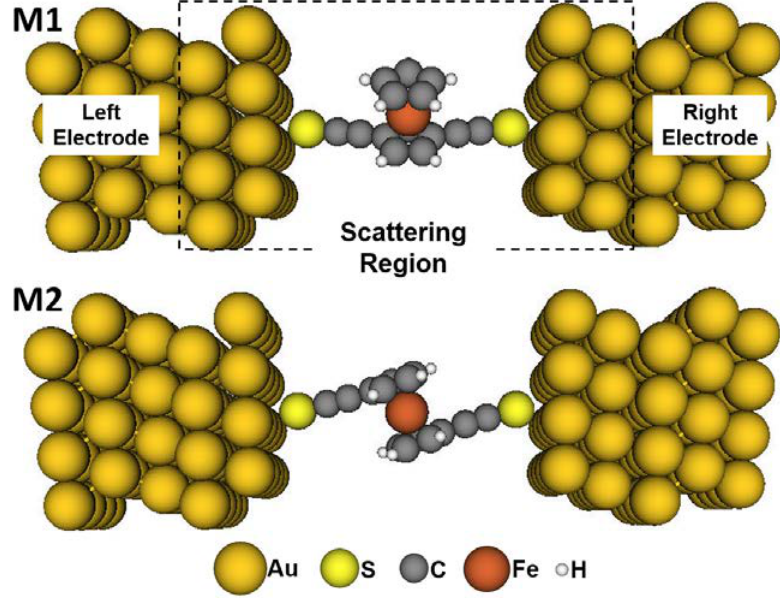
Figure 2. Models M1 and M2 of the ethynyl ferrocene molecular junctions. Au, S, C, Fe, and H atoms are represented by the golden, yellow, gray, brown, and white balls, respectively.